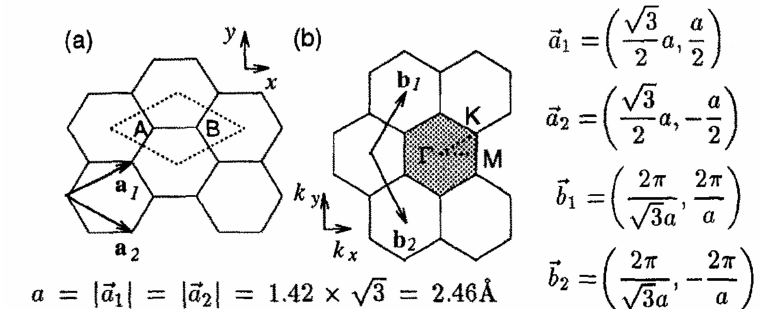
Figure 16. Graphene lattice and reciprocal lattice, { (cid:126) a 1 , (cid:126) a 2 } and { (cid:126) b 1 , (cid:126) b 2 } basis and reciprocal basis vectors,